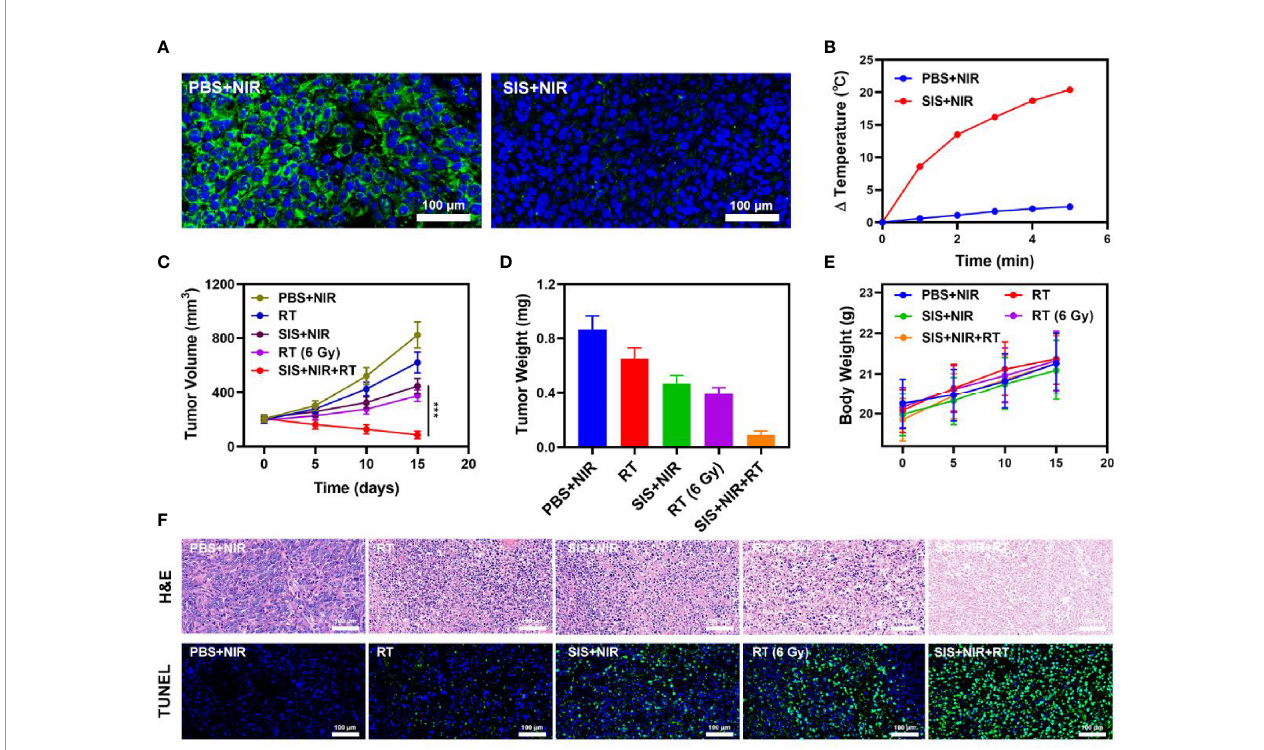
FIGURE 3 | (A) Representative images of tumor tissue sections stained with anti-PIMO (green) and DAPI (blue) following the indicated treatments. (B) Temperature increases in mice implanted with 4T1 tumors following 808 nm laser irradiation (0.5 W/cm2) for 5 min in the indicated treatment groups. (C) Tumor volume change over time in groups treated as indicated. (D) Average tumor weight values associated with the indicated treatments. (E) Changes in body weight in response to the indicated treatments. (F) H&E and TUNEL stained tumor sections from the indicated treatment groups. ***P < 0.005; Student ’ s t-test.